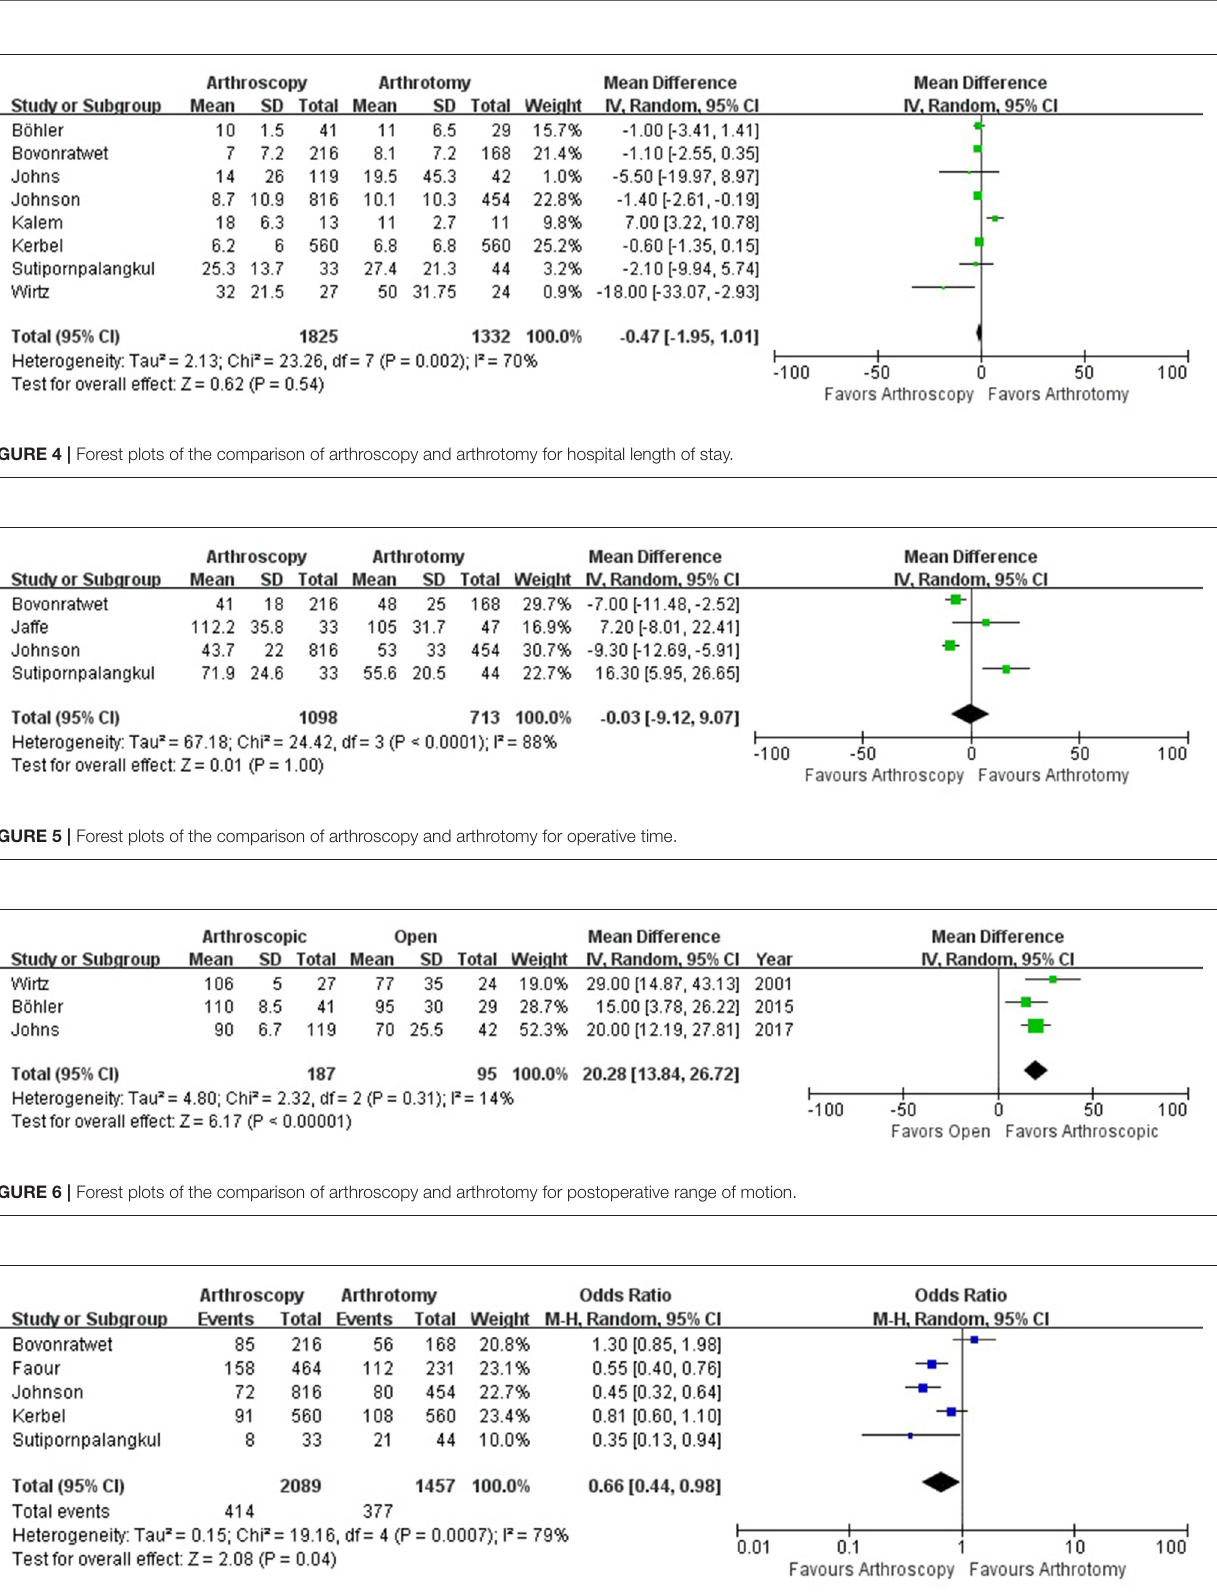
FIGURE 7 | Forest plots of the comparison of arthroscopy and arthrotomy for overall complications.